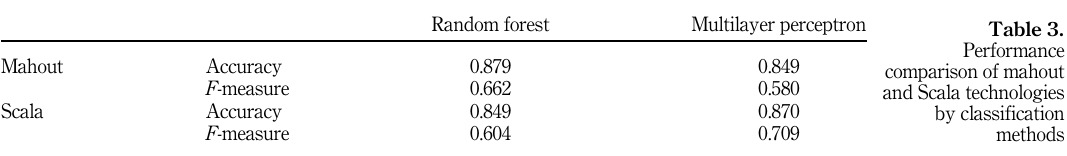
comparison of mahout and Scala technologies by classification